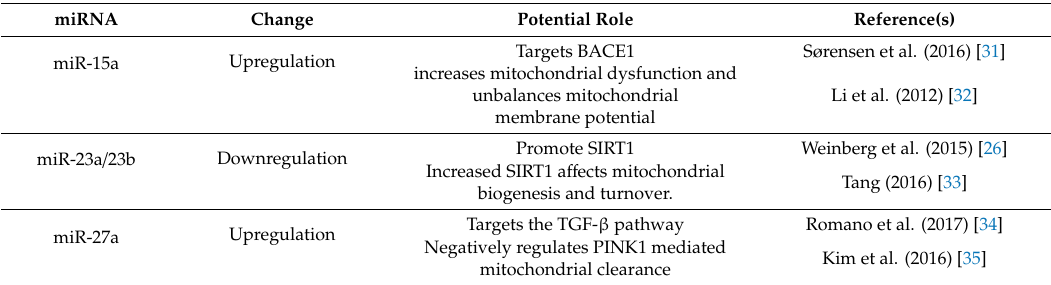
Table 1. Mitochondrial microRNAs related to Alzheimer’s